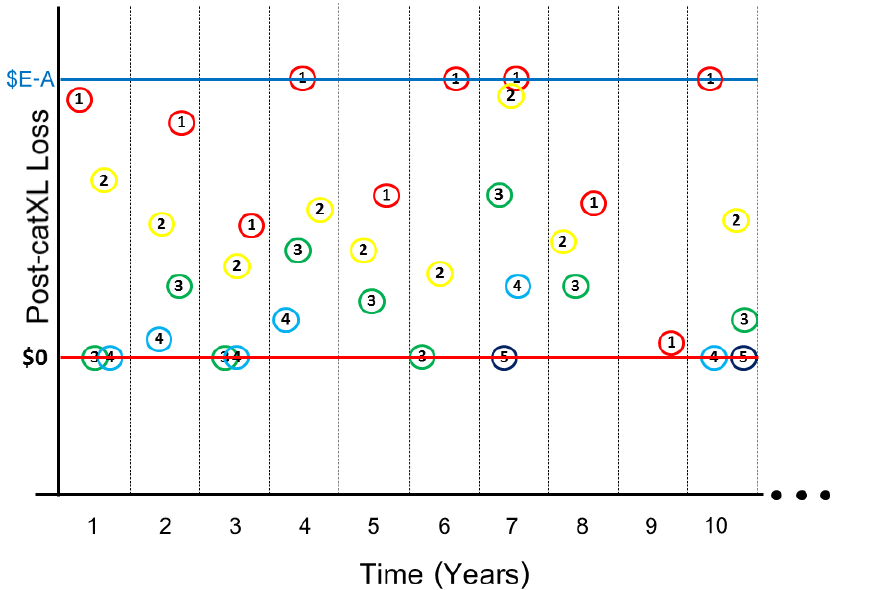
Figure 2. This picture illustrates the application of a catXL contract to the pre-catXL timeline simulation depicted in Figure 1. Occurrence losses in Figure 1 below the attachment point are given $0 value. Occurrence losses greater than or equal to the attachment point, but less than the exhaustion point, are equal to the assigned value in Figure 1, minus the attachment point. All occurrence losses above the exhaustion point in Figure 1 are assigned a value of $(E-A). In all simulation years, all higher order occurrence losses which are not depicted are assigned $0